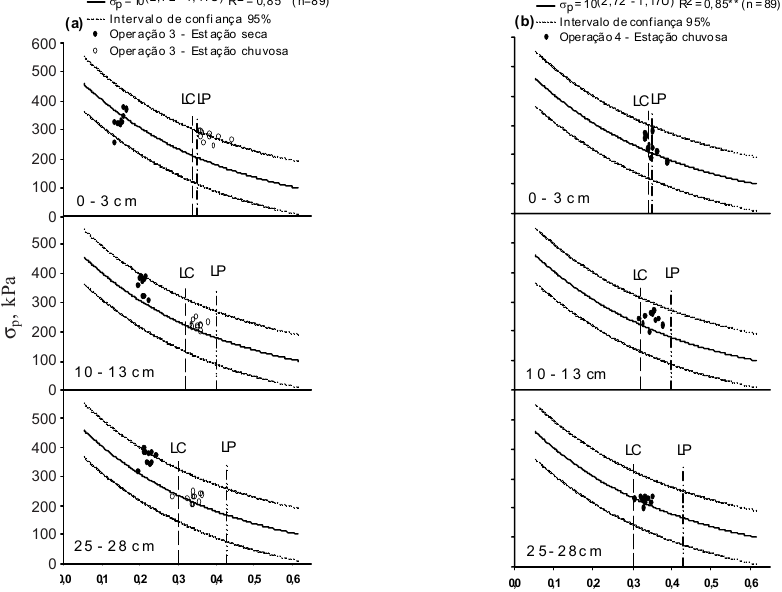
Figura 4. Modelo de capacidade de suporte de carga para o Latossolo Amarelo distrófico típico nas camadas de 0–3, 10–13 e 25–28 cm com seus respectivos limites de contração (LC) e de plasticidade (LP). Os pontos representam as pressões de preconsolidação determinadas após as operações da roçadora tracionada pelo trator Massey Ferguson 50X na estação seca e tracionada pelo trator Massey Ferguson 50X e 265 na estação chuvosa (Operação 3) (a), as pressões de preconsolidação determinadas após as operações da granuladora tracionada pelo trator Massey Ferguson 50X na estação chuvosa (Operação 4) (b).